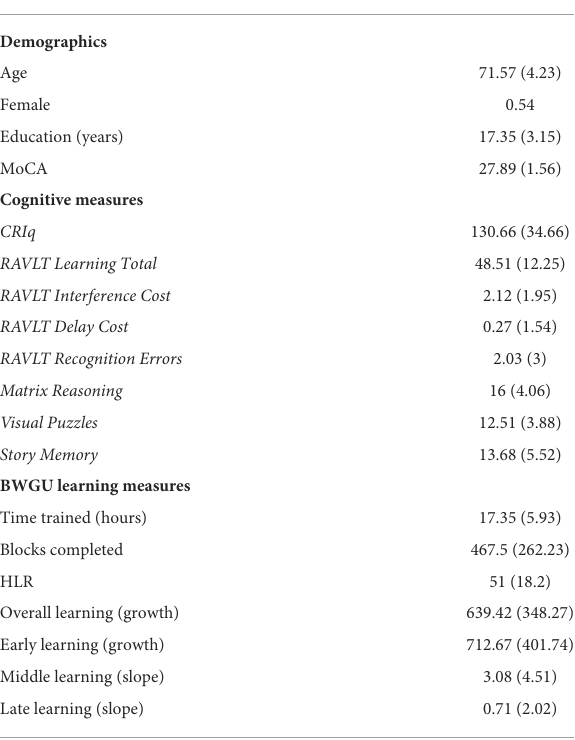
TABLE 1 Summary statistics for demographic variables, cognitive measures,andthe BirdWatch Game—Unity (BWGU)learningmeasures.